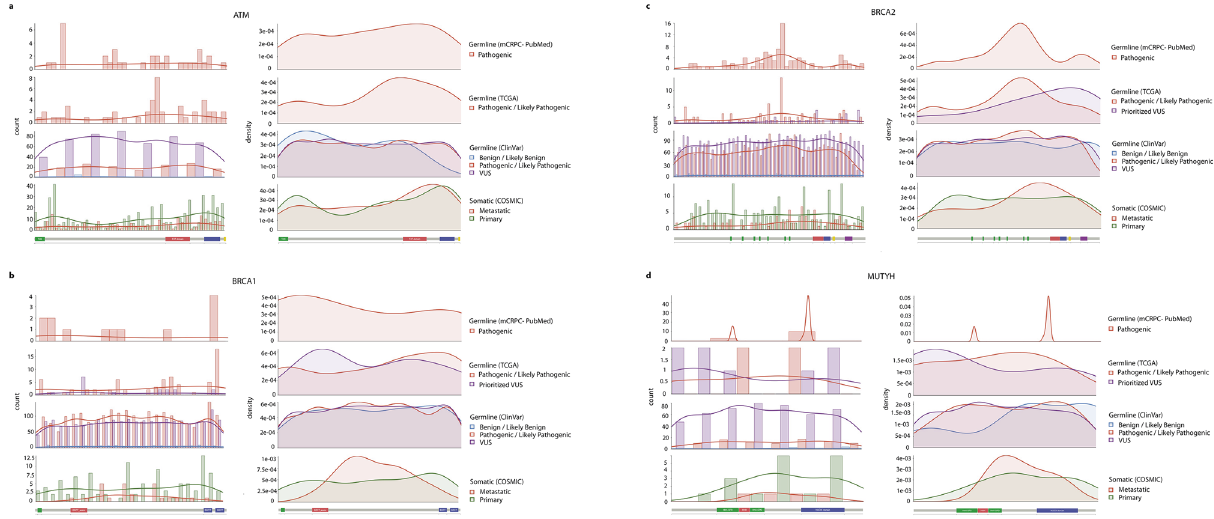
Figure 6. Co-localization of germline and somatic variants in ATM, BRCA1, BRCA2 and MUTYH. Panel ( a ): Histograms and density distributions for different types of variants in ATM. The histograms in the left-hand column show the counts of each variant type in bins of 75 residues along the sequence. They show: germline variants identified in different cohorts of mCRPC collected from the literature (PubMed), germline variants from TCGA, germline variants from ClinVar, and somatic variants from COSMIC. Where more than one type of variant is plotted the widths of the bars in each bin are reduced accordingly. To the right of each histogram are the equivalent density distributions, as computed by smoothing the histogram bars. A small version of the Pfam domain layout is also shown beneath the histograms and density distributions. Panels ( b – d ) show the data for BRCA1, BRCA2, and MUTYH, respectively. ATM BRCA1 BRCA2 MUTYH D 0.078415 COSMIC Metastatic/Primary